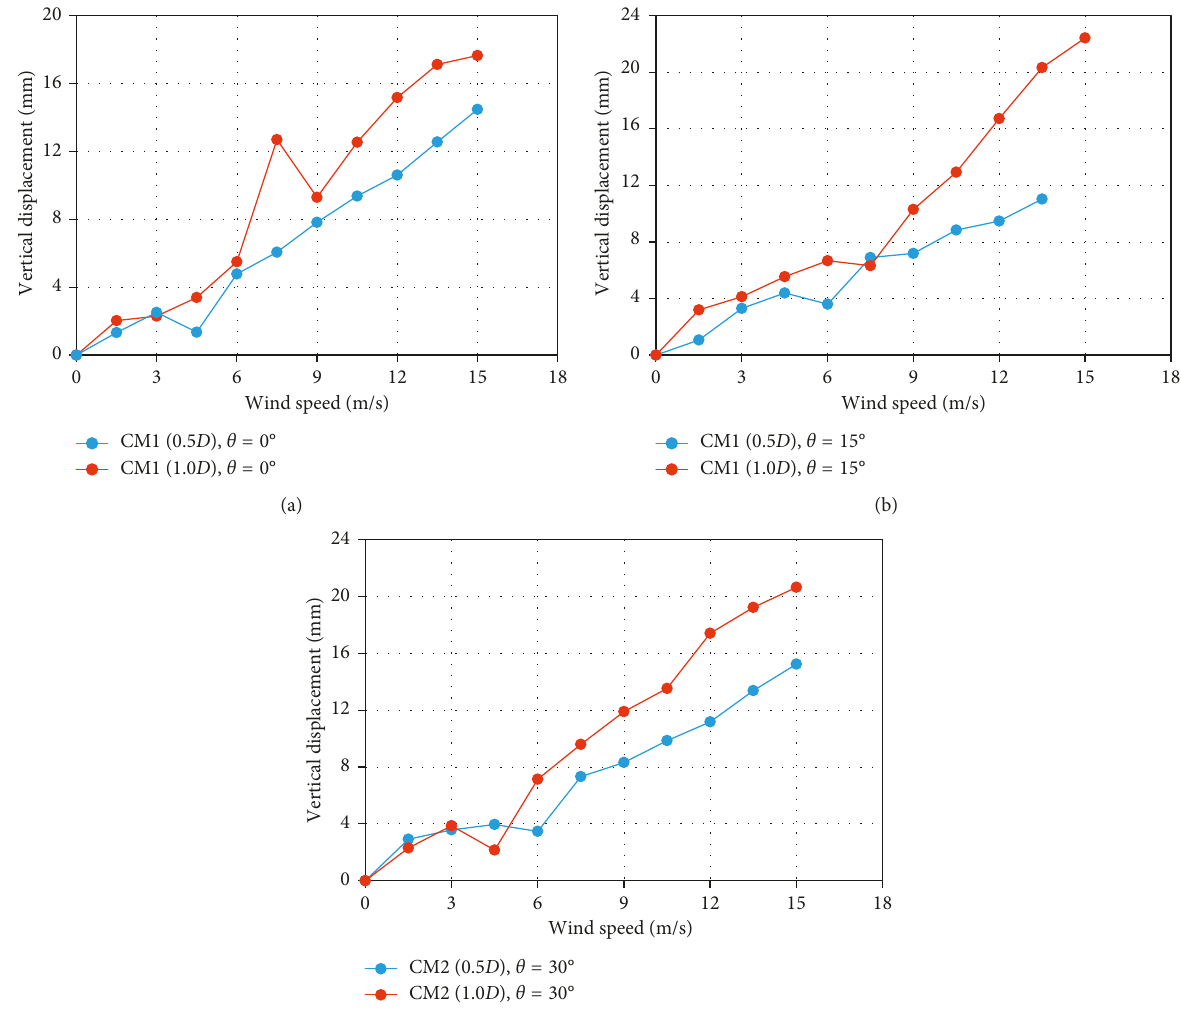
Figure 8: Variation of mean vertical response with wind speed for cable models with 0.5D and 1.0D ice thickness: (a) CM1 at θ � 0 ° ; (b) CM1 at θ � 15 ° ; (c) CM2 at θ � 30 °